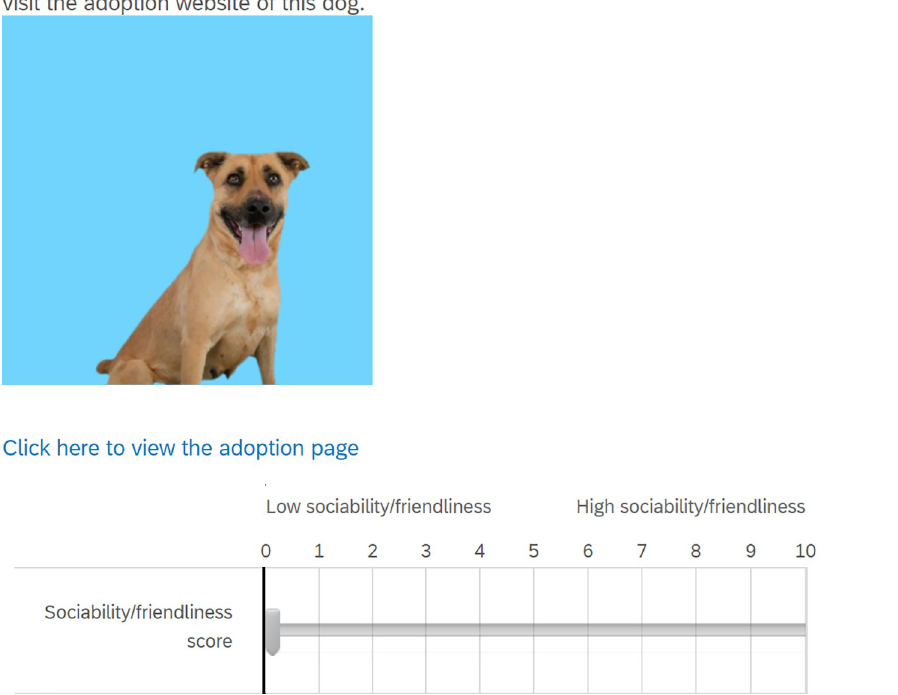
Fig 2. Sample question provided to participants on Qualtrics. For each dog a) a sociability/friendliness score slider is provided and b) a link for participants to access the adoption website specific to the dog featured in the photograph is